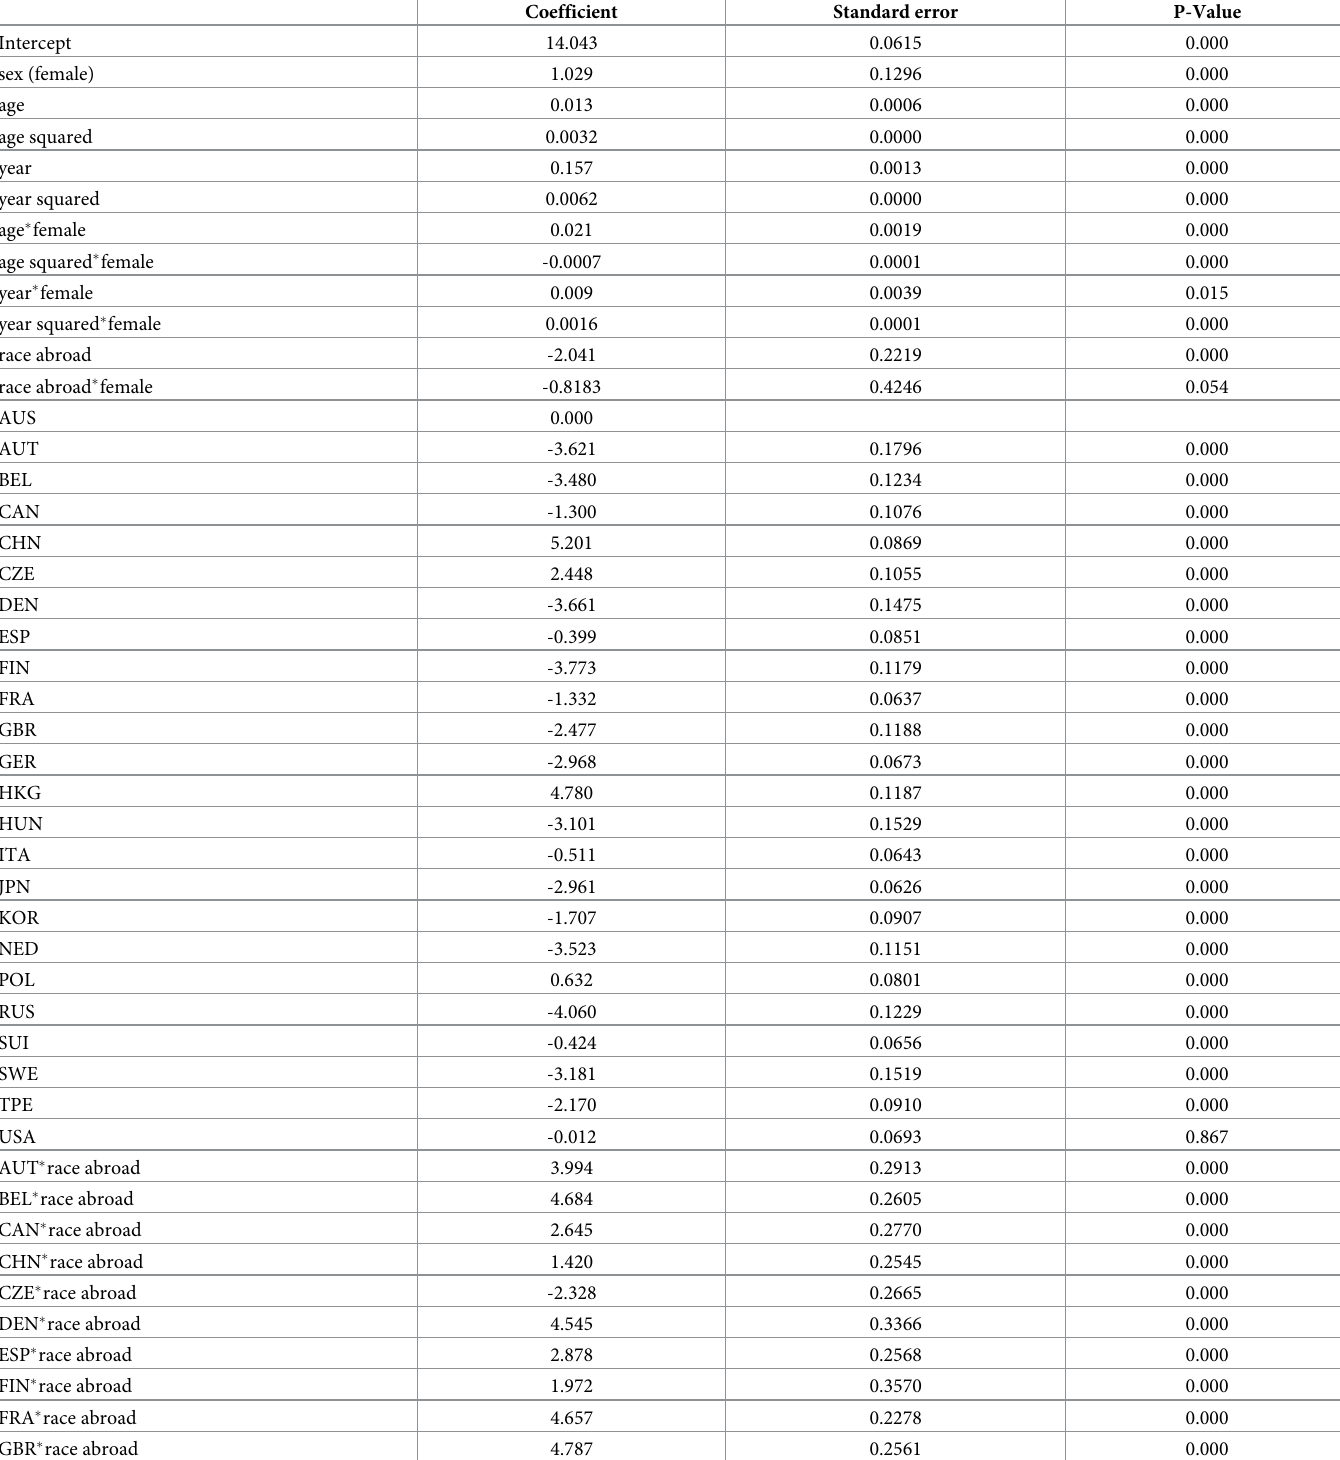
Table 13. Interaction with race site, results from truncated regression with complete data set time = sex × (year+year 2 )+sex × (age+age 2 ) + sex × nationality × site and referenced to male, age 44, year 2009 and nationality Australia. R 2 =